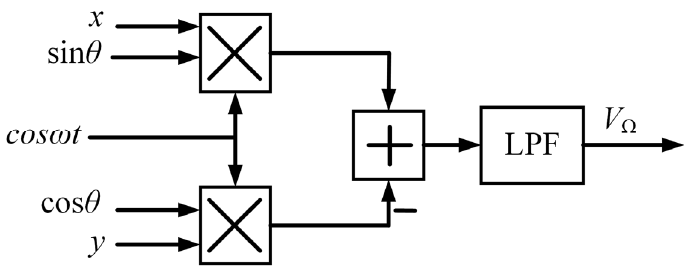
Figure 2. Block diagram of obtaining the detected angular rate V Ω .